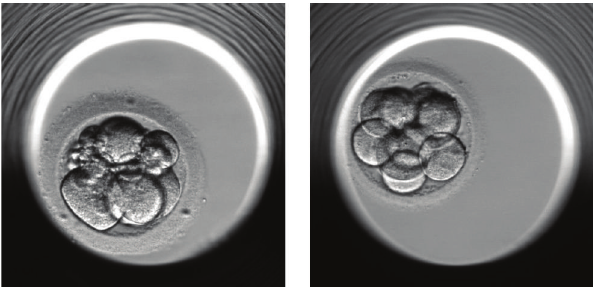
Figure 1: Two embryos: with normal morphokinetics in Embryoscope and with normal PGS (2nd and 6th